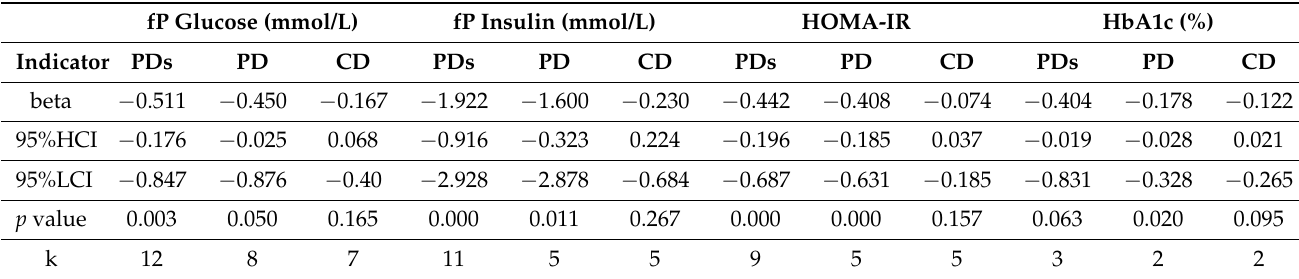
Table 8. Changes in carbohydrate metabolism (fP glucose, fP insulin, HOMA-IR, and HbA1c) in short-term PDs, PD, and CD studies (up to 6 months).